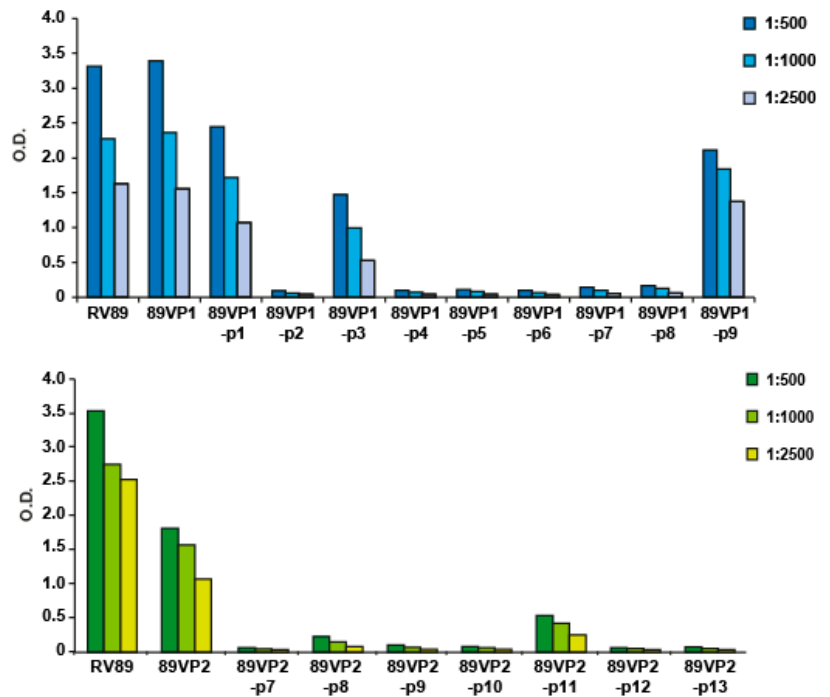
Figure 4. Reactivity of three dilutions of anti-RV89 guinea pig IgG antibodies to purified RV89, recombinant RV89 capsid proteins and synthetic peptides ( x -axes). Bound IgG antibodies correspond to optical density values (O.D., y-axes). PreS-P1-P5 as well as MBP were used as negative controls.